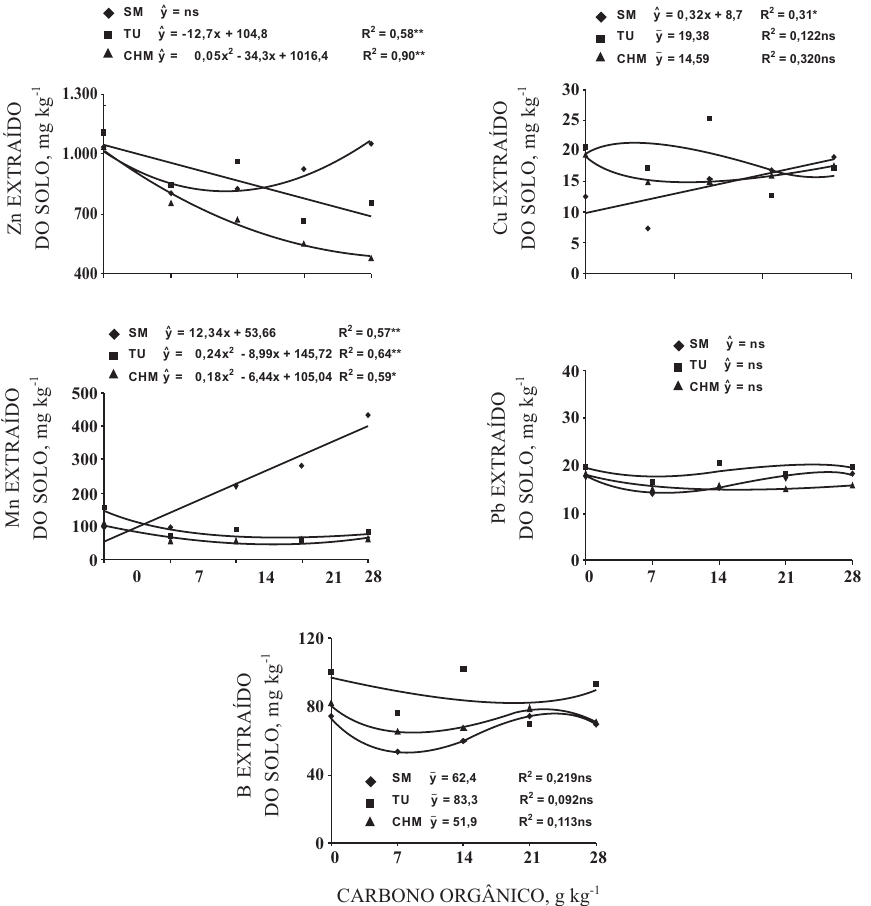
Figura 3. Teores de de zinco, cobre e manganês na parte aérea da mostarda em função de doses de carbono orgânico aplicadas ao solo via solomax (SM), turfa (TU) e concentrado húmico mineral (CHM). (ns) não- significativo. (**) e (*) significativos a 1 e 5 %,